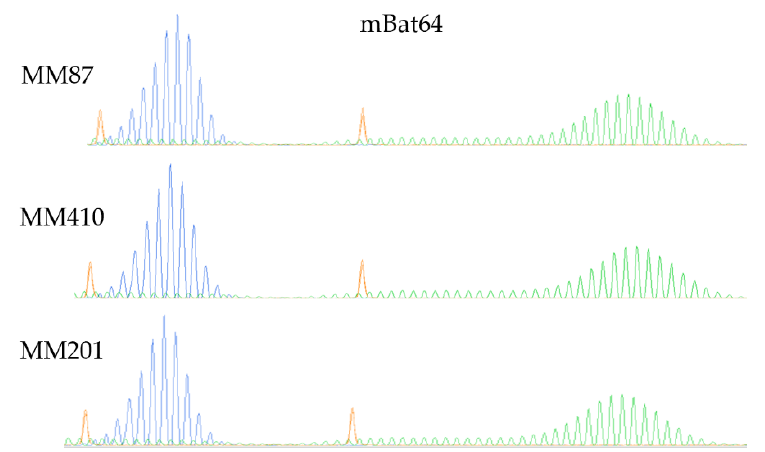
Figure 4. MSI detection in MMe cell lines by fragment analysis. MMe cells are in blue, wt tail DNA